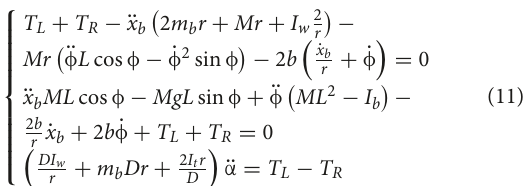
centers of the two wheels and the left and right wheel angles is: x b = 1 / 2 ( θ L + θ R ) . I w is the moment of inertia of the wheel, F x is the interaction force between the wheel and the body in the X -axis direction, F z is the interaction force between the wheel and the body in the Y -axis direction, T L and T R are the output torques of the left and right wheel motors, respectively, T fL and T fR are the friction torque, b is the friction coefficient between the wheel and the rod, the support force between the wheel and the ground is F n , and the friction force is F s